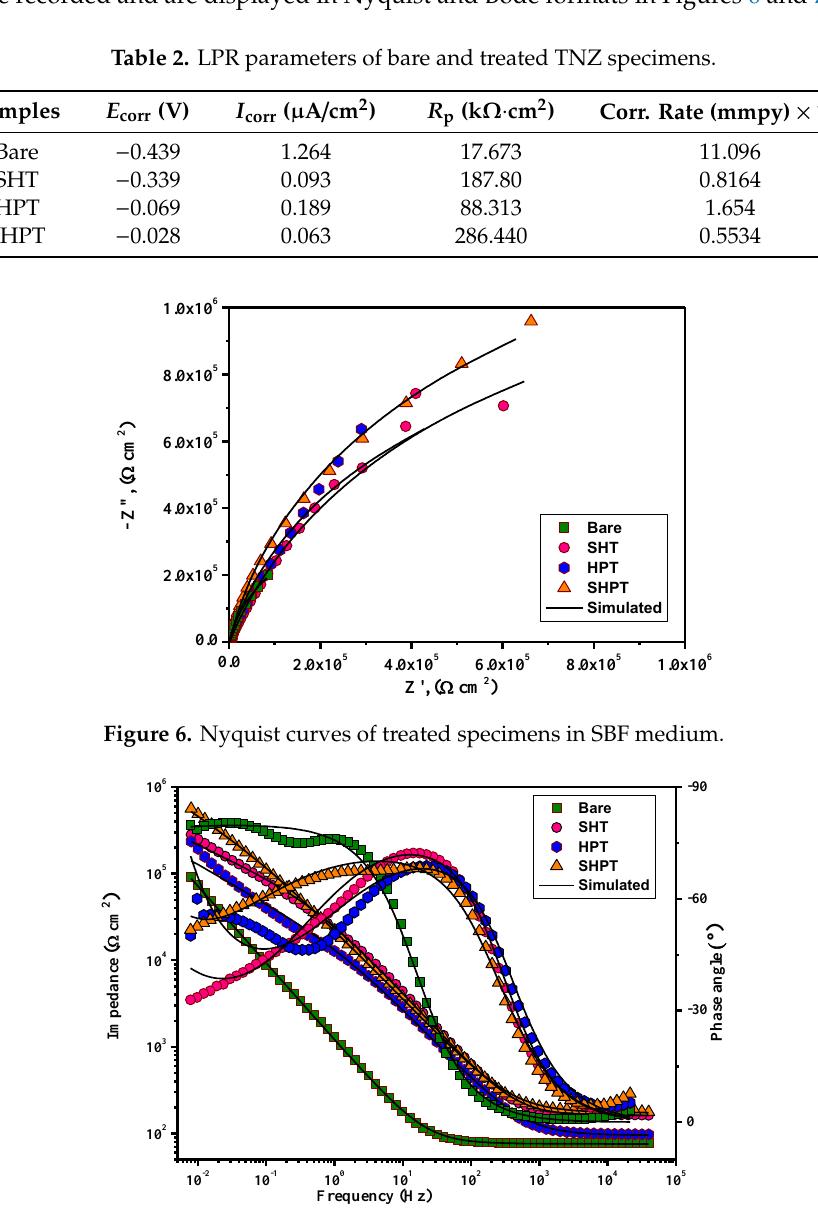
Figure 7. Bode plots of treated specimens in SBF medium.